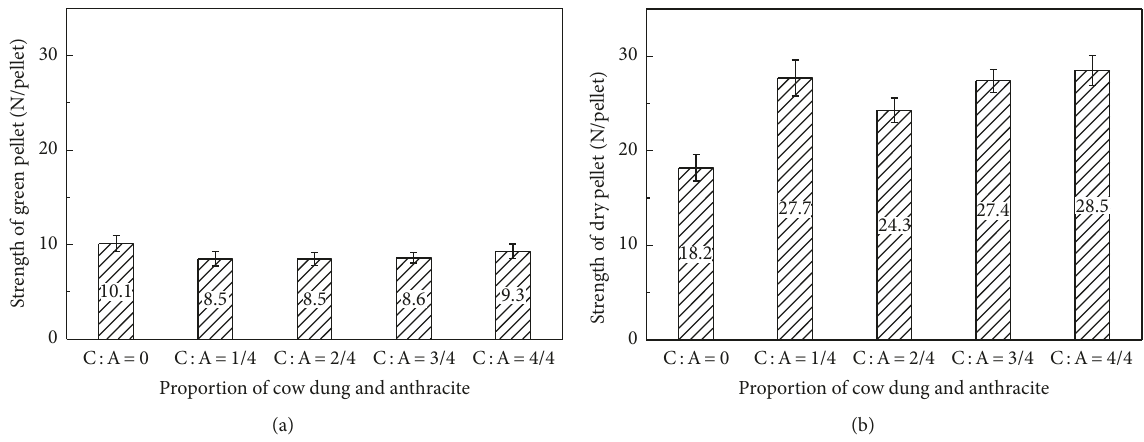
Figure 2: Cold strength of carbon-bearing pellets with different proportions of cow dung. (a) Green pellet; (b) dry pellet.